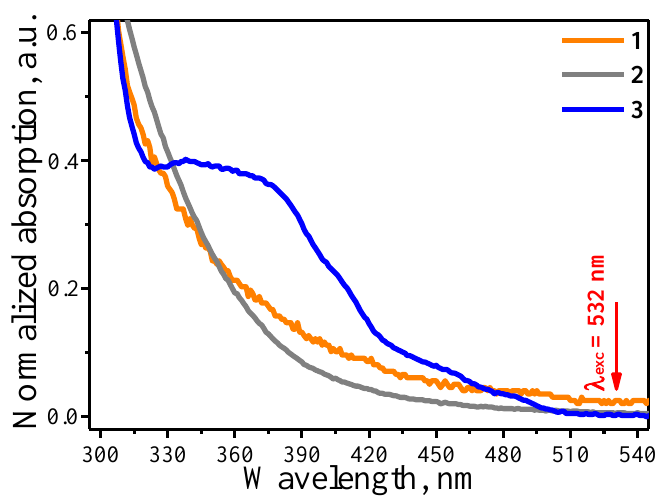
Figure 1. UV-vis absorption spectra normalized to unity at the absorption maximum of the DMF solutions of triphenylphosphine chloride of gold(I) (1), dicyclopentadienyl platinum(II) dichloride (2) and tris(2-phenylpyridine)iridium(III) (3).